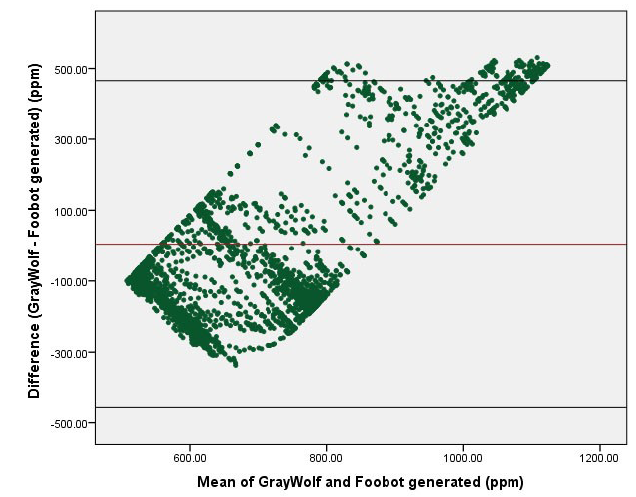
Figure 13. Bland–Altman plot of the agreement between the Gray- Wolf PC-3016A and the Foobot-generated PM 2 . 5